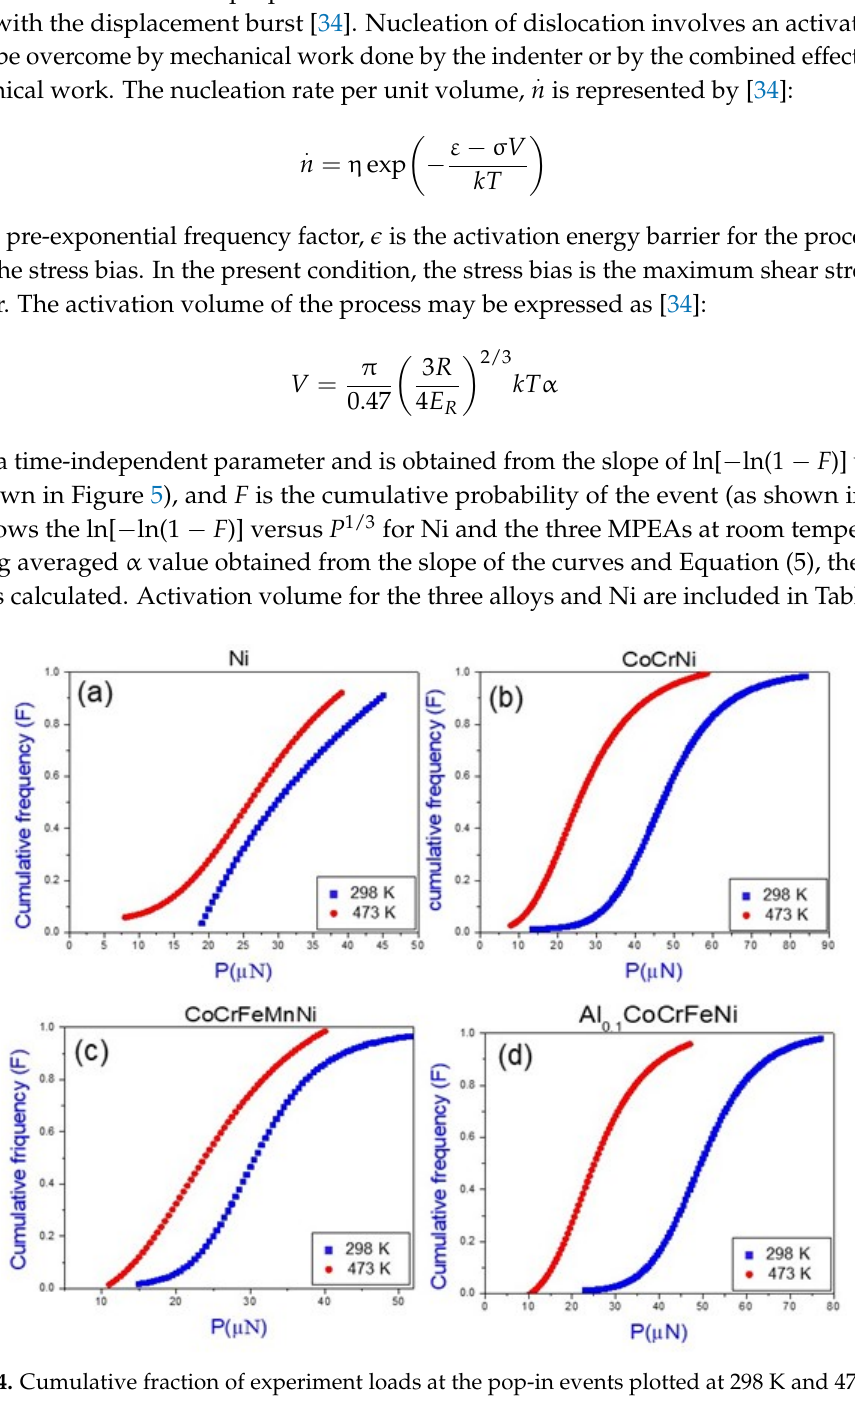
Figure 4. Cumulative fraction of experiment loads at the pop-in events plotted at 298 K and 473 K for ( a ) Ni, ( b ) CoCrNi, ( c ) CoCrFeMnNi, and ( d ) Al 0.1 CoCrFeNi